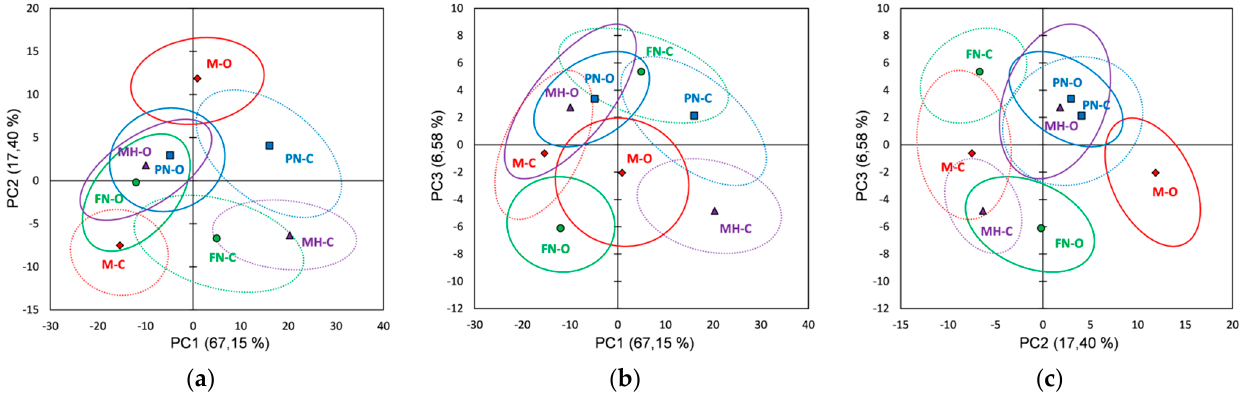
Figure 8. Score plots of the first three principal components derived from Raman data of the red grape pulp extracts (the